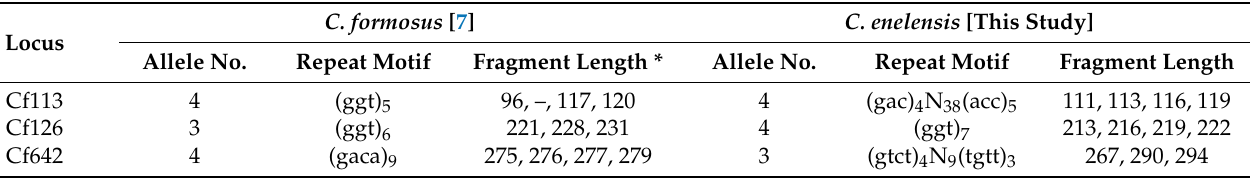
Table 4. Comparison of the three microsatellite loci between the two chanterelle species. C. formosus [7] C. enelensis [This Study] Locus Allele